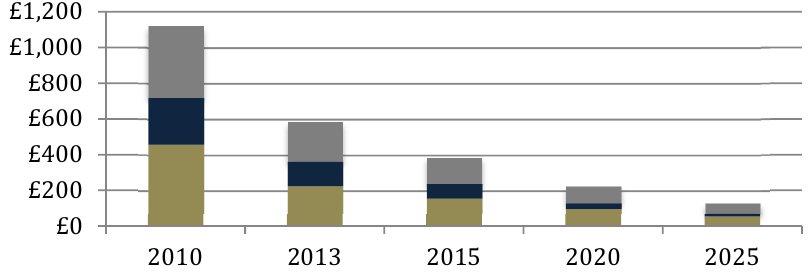
Figure 3. Battery pack production cost reductions, 2010–2020 (£/kWh). Sources: Published Tesla cost data; conversations with industry experts, including